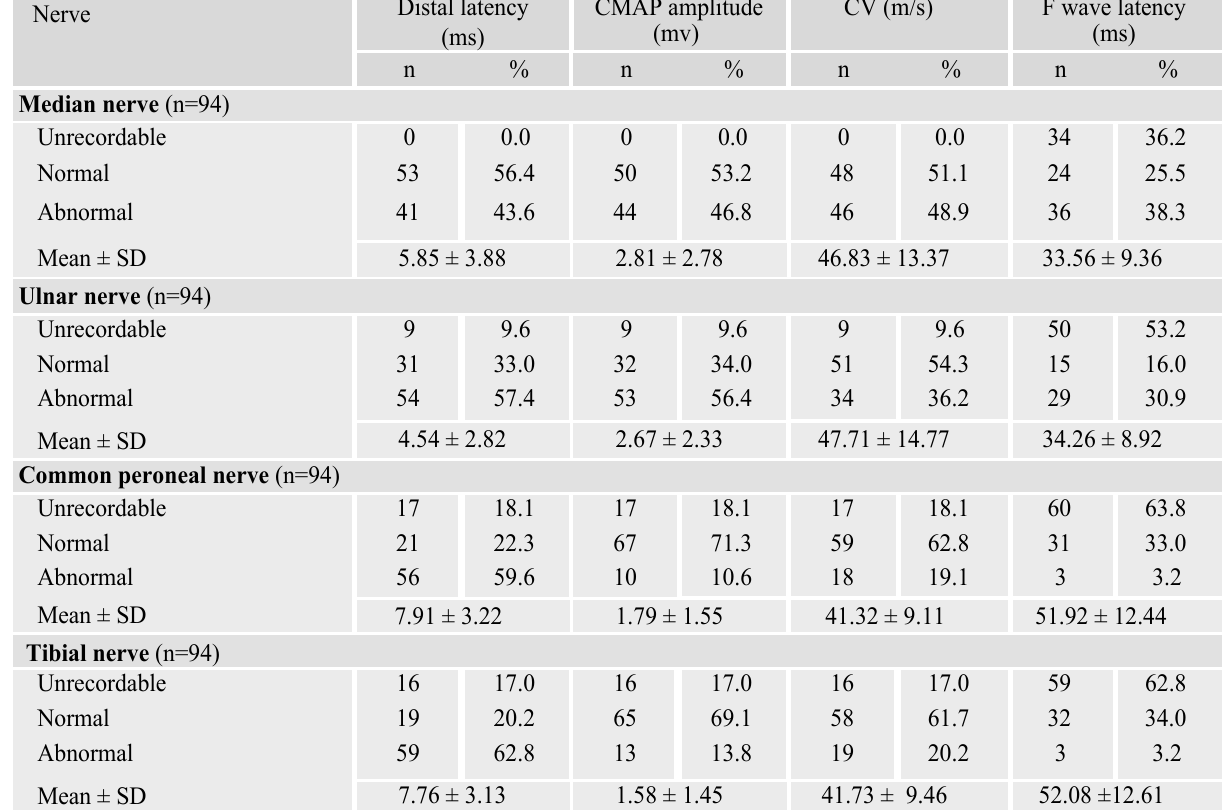
Table I: Results of motor nerve conduction studies of study